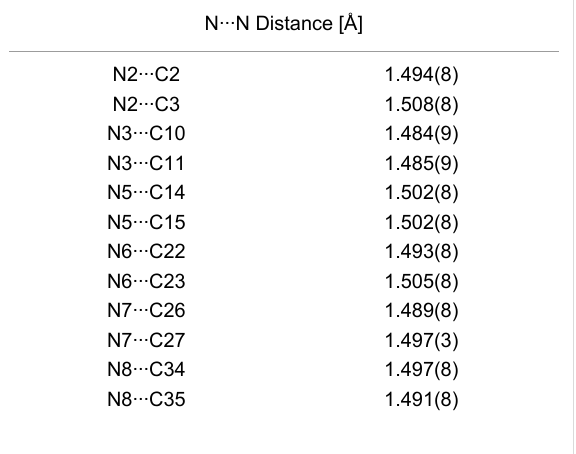
Table 1: Selected non-bonded distances (Å) of complex 1